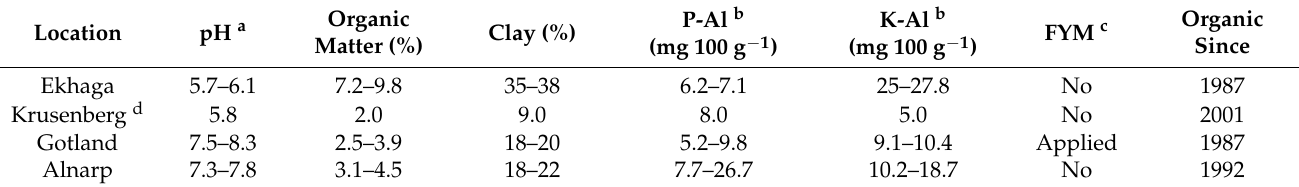
Table 2. General characteristics of soil at different